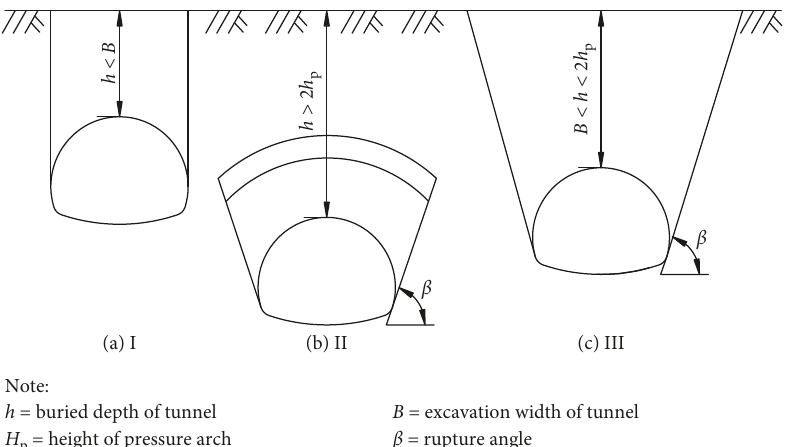
Figure 1: Three failure modes of shallow-buried tunnel.